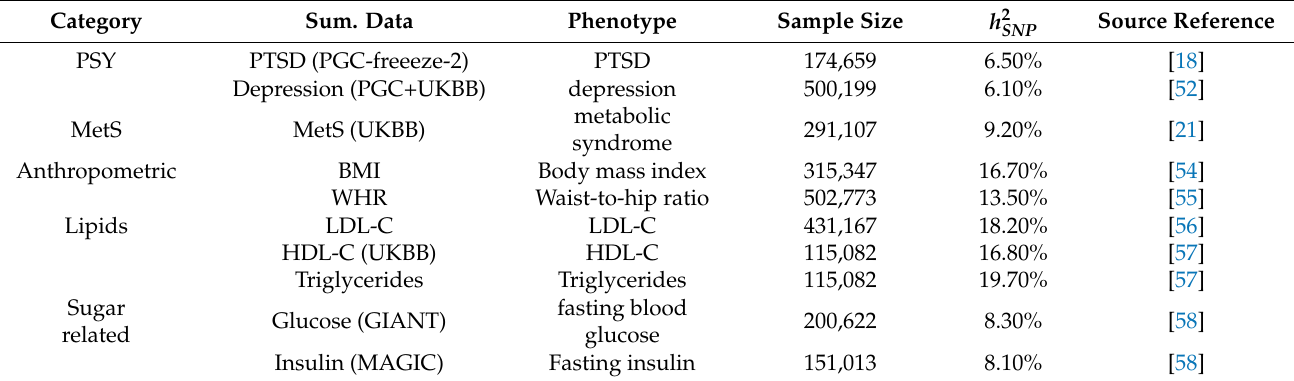
Table 4. GWAS summary statistics used in the current